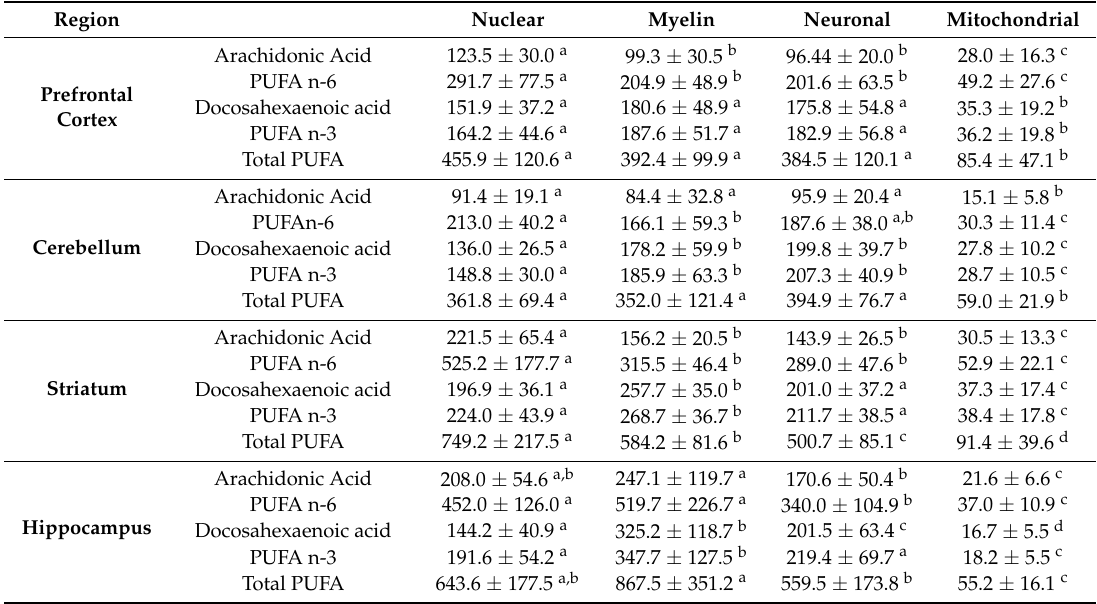
Table 2. Membrane polyunsaturated fatty acid concentration ( µ g/mg protein, mean ± SD) in the prefrontal cortex, cerebellum, striatum, and hippocampus of adult rhesus macaques ( n = 9).